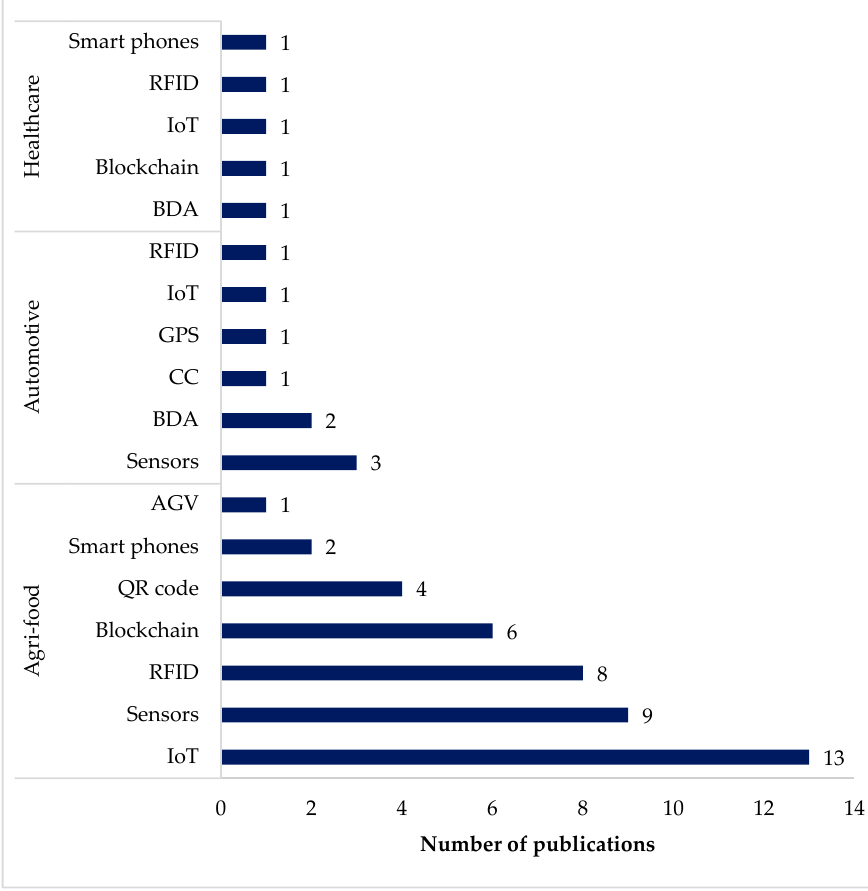
Figure 9. Type of technology applied in the three common sectors.